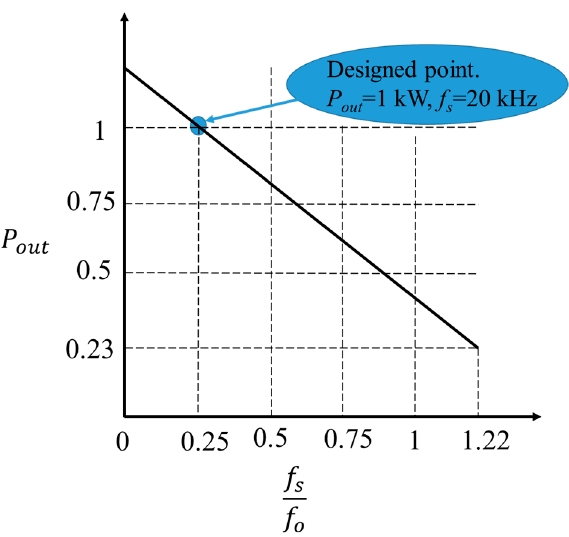
Figure 7. Output power characteristic with respect to the switching frequency of the transformer. By increasing the transformer frequency f s , the output power P out can be reduced. In Figure 7, the output power is notarized as P out = 1 at the frequency ratio ( f s / f o ) = 1/4. The maximum frequency ratio ( f s / f o ) is the condition in which the duration of Mode 2–4 max